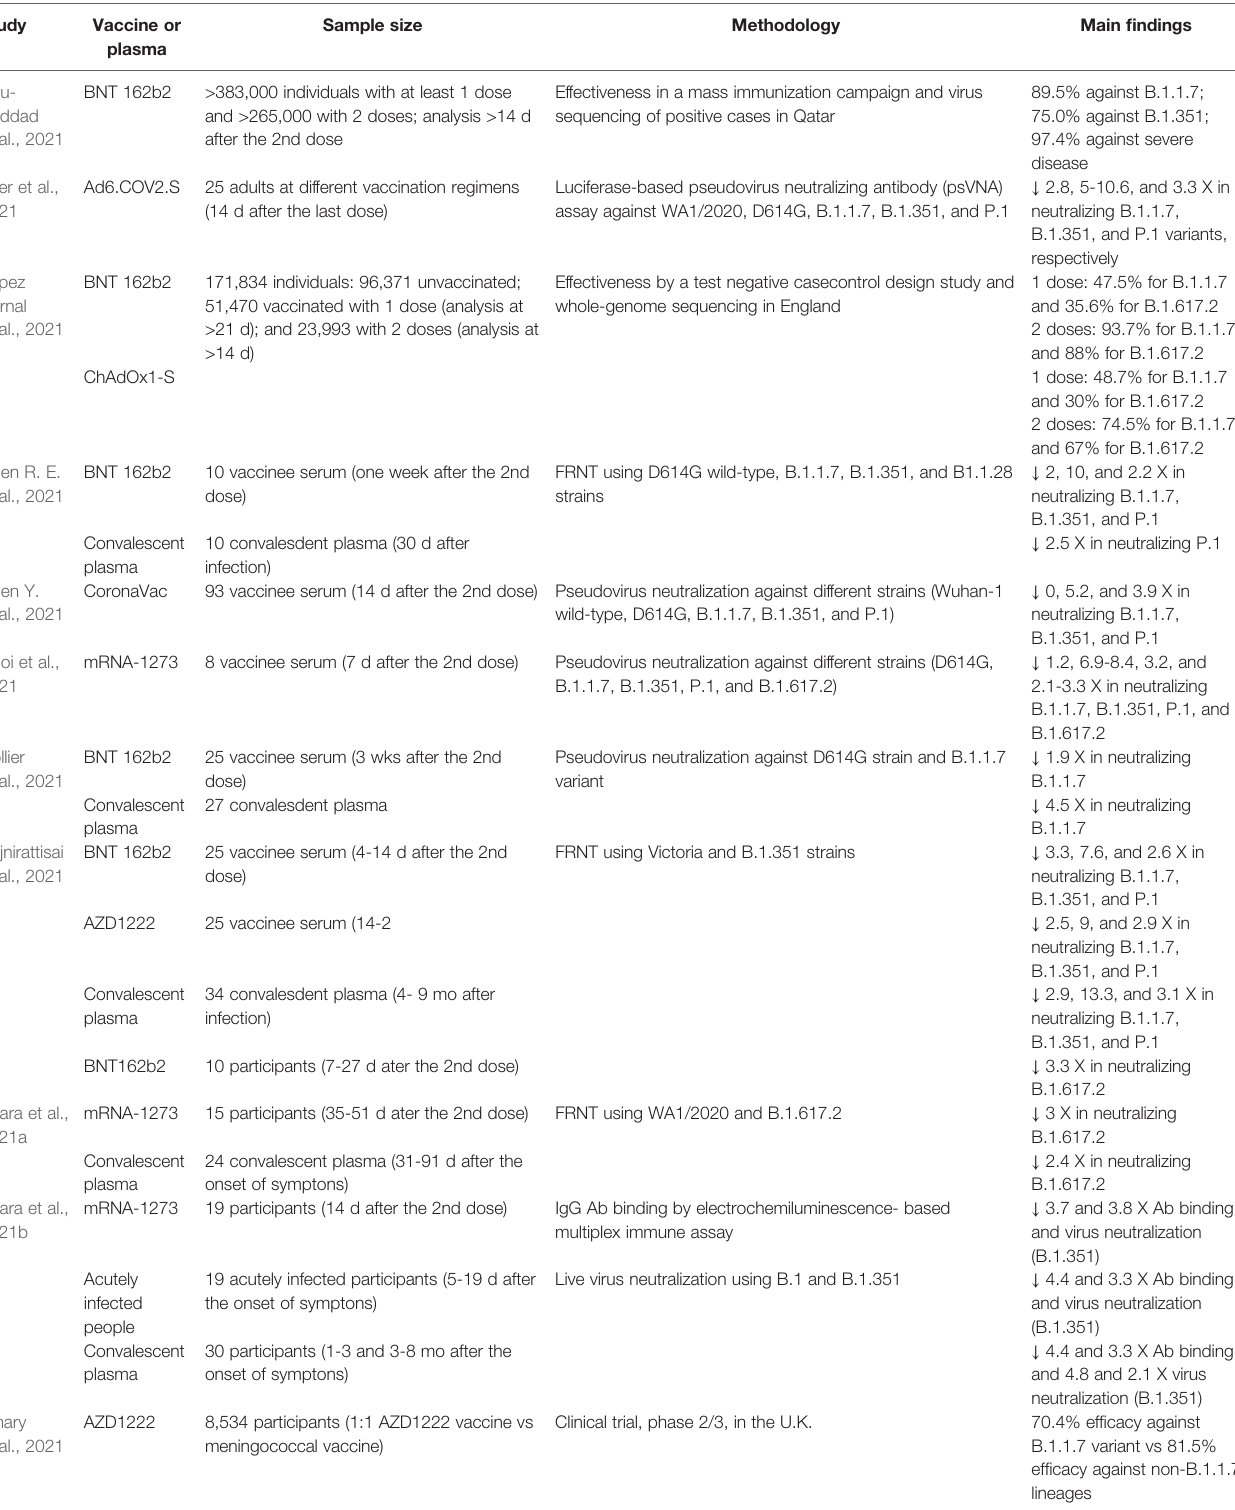
TABLE 2 | Studies about ef fi cacy/effectiveness and neutralizing antibody activity of vaccines and convalescent plasma against SARS-CoV-2 variants. Study Vaccine or